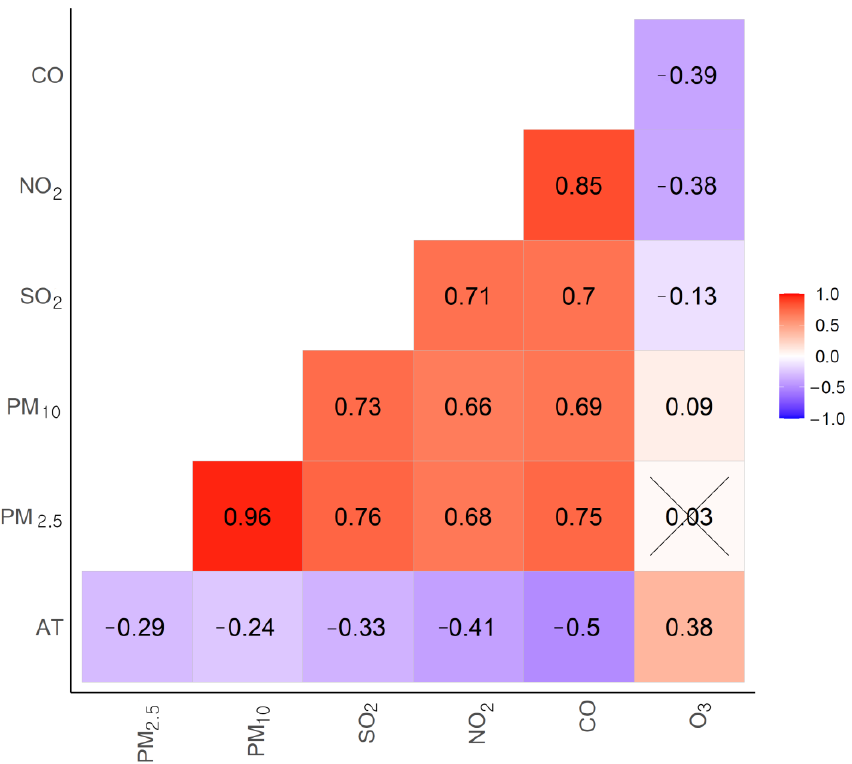
Figure 4. Spearman’s correlation analysis of modeled PM 2.5 and monitored air pollutants PM 10 , SO 2 , NO 2 , CO, and O 3 ) and apparent temperature during the study period. All correlation coefficients were statistically significant ( p -value < 0.05). Statistically insignificant correlations are indicated by